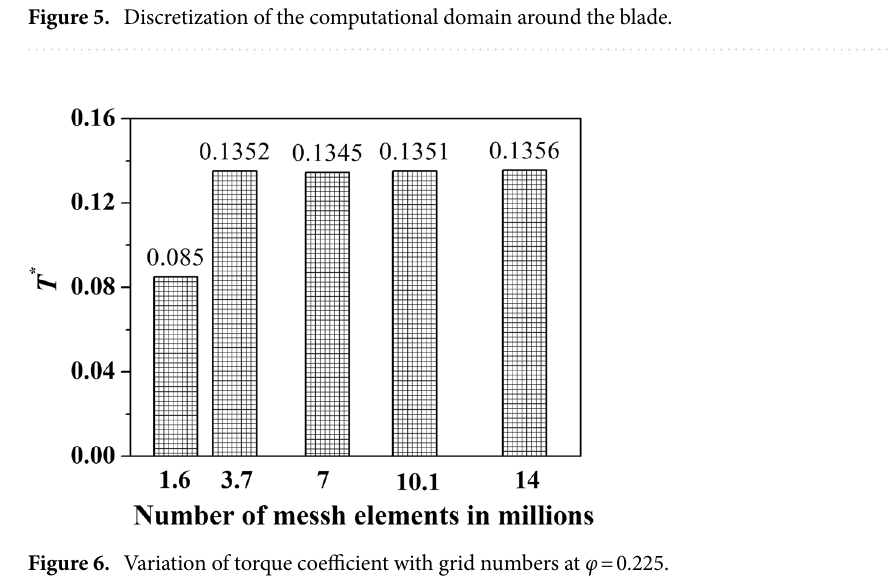
Figure 5. Discretization of the computational domain around the blade.